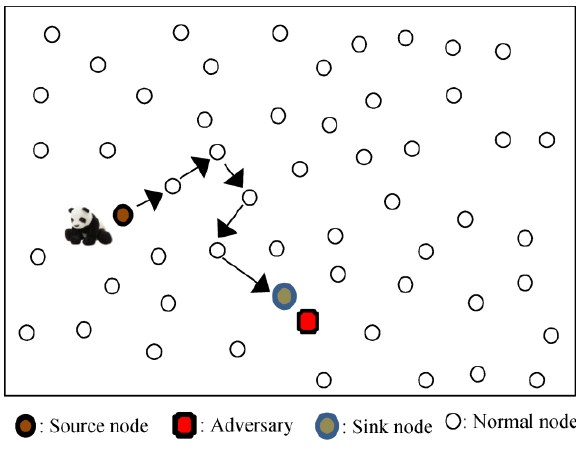
Figure 1. Example source node, sink node, and adversary configuration in a WSN.